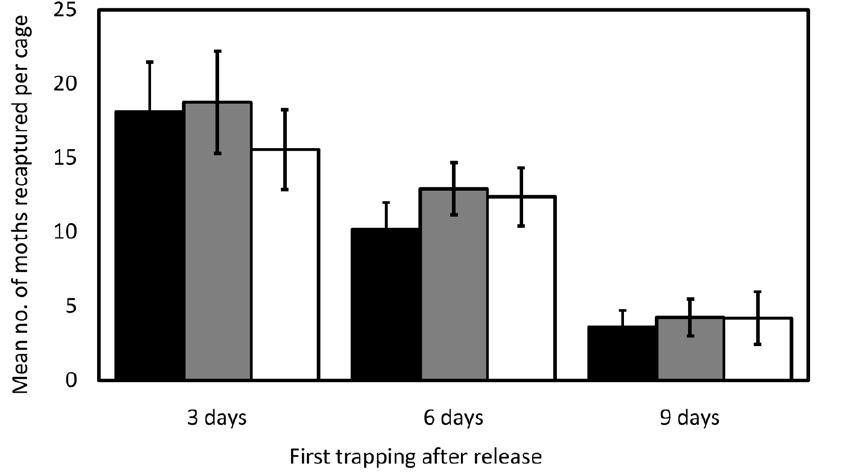
Figure 2. Mean recapture of three moth types in cages with pheromone-baited traps first set 3 days, 6 days or 9 days after release. Black bars=OX1138B 100 Gy; grey bars=APHIS 100 Gy; white bars=APHIS 200 Gy; error bars indicate Standard Error of Mean. There were no significant differences in recaptures between the groups on the first day of trapping or total recaptures (logistic regression model, p=0.07 and p=0.10,